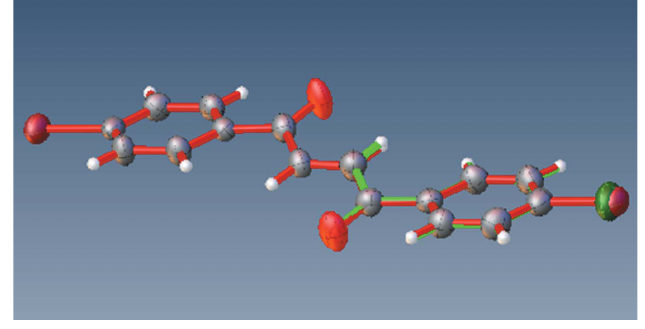
Figure 2 Superimposition of structure ( 1 ) (green) onto the inverted structure of ( 2 ) (red). Only the asymmetric unit of ( 1 ) is presented for clarity.